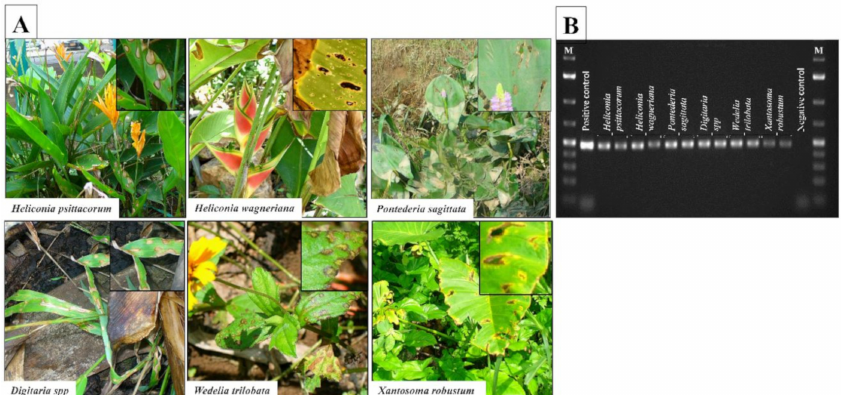
Figure 1. Potential alternative hosts of P. fijiensis . ( A ) Plants collected inside and around commercial banana crops, with symptoms similar to those induced by P. fijiensis in banana plants (leaf spots). Pictures in the boxes, close ups of symptoms. ( B ) PCR-based diagnostic of P. fijiensis . Those amplifying the expected diagnostic DNA product, a 500 bp fragment of actin gene, are presented. Positive control, gDNA of P. fijiensis ; negative control, no DNA but water. M) Molecular marker (1 kb plus